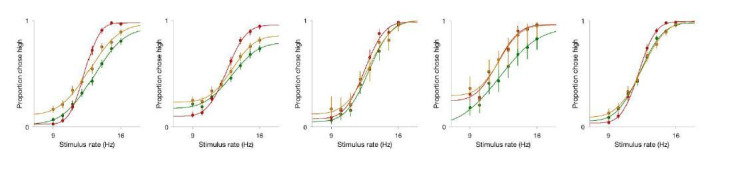
Bias in psychometric functions of individual rats.Data from the 5 rats used in the neutral experiment, on auditory (green), neutral (orange) and multisensory (red) conditions, demonstrating individual variability in low-rate bias on auditory trials, compared to neutral/multisensory trials. Some rats (e.g. rightmost panel) show almost no bias, resembling the “rate-only” decoders, while others resemble “hybrid” decoders with weak influences fromcount information.